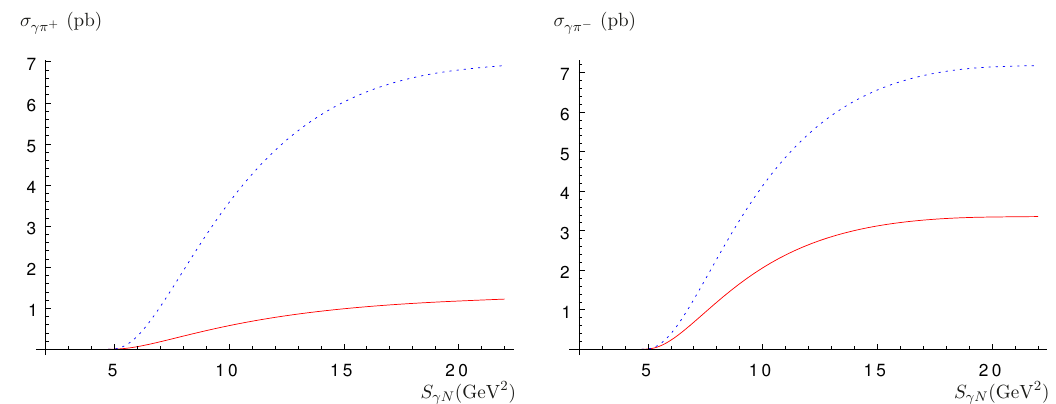
Figure 7 . Left: integrated cross section for the production of a large mass γπ + pair on a proton target. Right: integrated cross section for the production of a large mass γπ − pair on a neutron target. The solid red curves correspond to the “valence” scenario while the dotted blue curves correspond to the “standard”